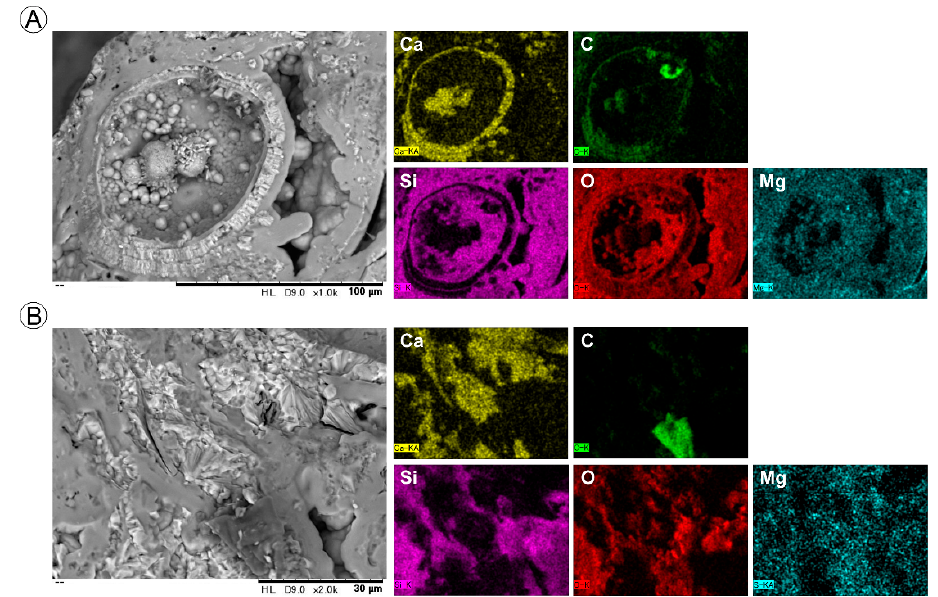
Figure 6. Element mappings of the cross-section of stalactite minerals. ( A ) calcium carbonate developing between ring structures; ( B ) banded carbonate structure. Ca: calcium, C: carbon, Si: silica, O: oxygen, and Mg: magnesium.